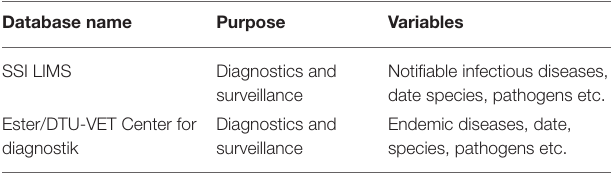
TABLE 2 | Databases on animal health in Denmark at national